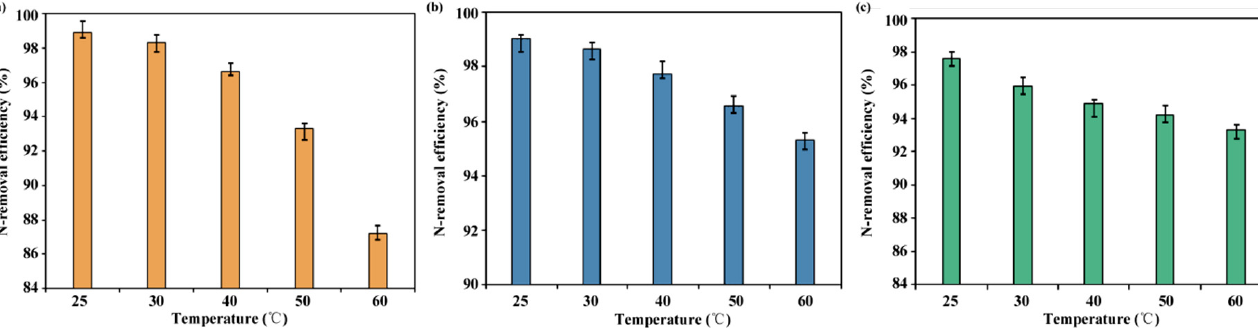
Figure 7. N-removal efficiency of the best IL with different oscillation speeds for pyridine, quinoline, and aniline. 4.2. Separation Kinetics The study of extraction kinetics can make us understand the separation process more deeply. In some cases, extraction kinetics are a function of chemical reaction speed and diffusion speed; the chemical reaction can include bond destruction and formation, mo- lecular polymerization or intermediation, and the reaction may occur in the phase or at the interface. These have an impact on the dynamic process. At the same time, the mass transfer of the diffusion process has a more complex effect on the kinetic process. For fur- ther analysis of related separation stages and mechanism, a kinetic study was carried out